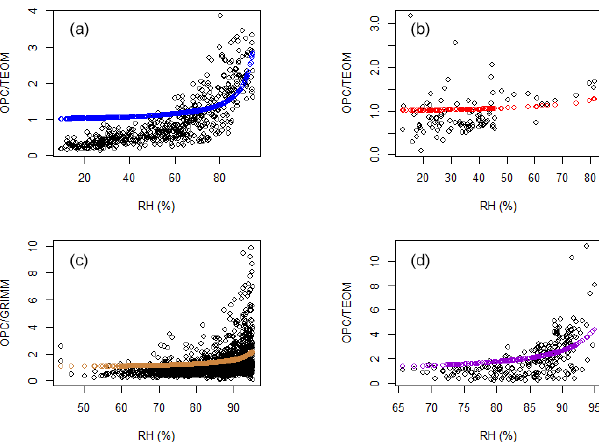
Figure 2. Humidograms with the corresponding κ fit (shown in colour) for Delhi (a) , Beijing (b) , Bham BAQS (c) and Bham Ty- burn (d) . Note the different y axis and x axis scales. The two-stage correction factor described in Sect. 3.3.1 has not been applied for these humidograms.